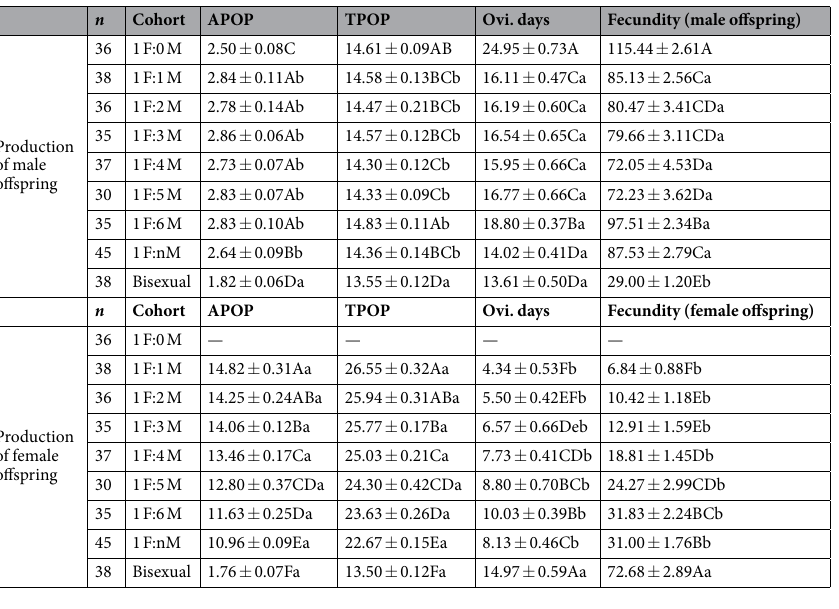
Table 2. APOP, TPOP, oviposition days, and fecundity of Frankliniella occidentalis producing male and female offspring. Means in the same column followed by the same upper case letter denotes no significant difference between different cohorts, while means followed by the same lower case letter denotes no significant difference between production of male and female offspring in the same treatments.